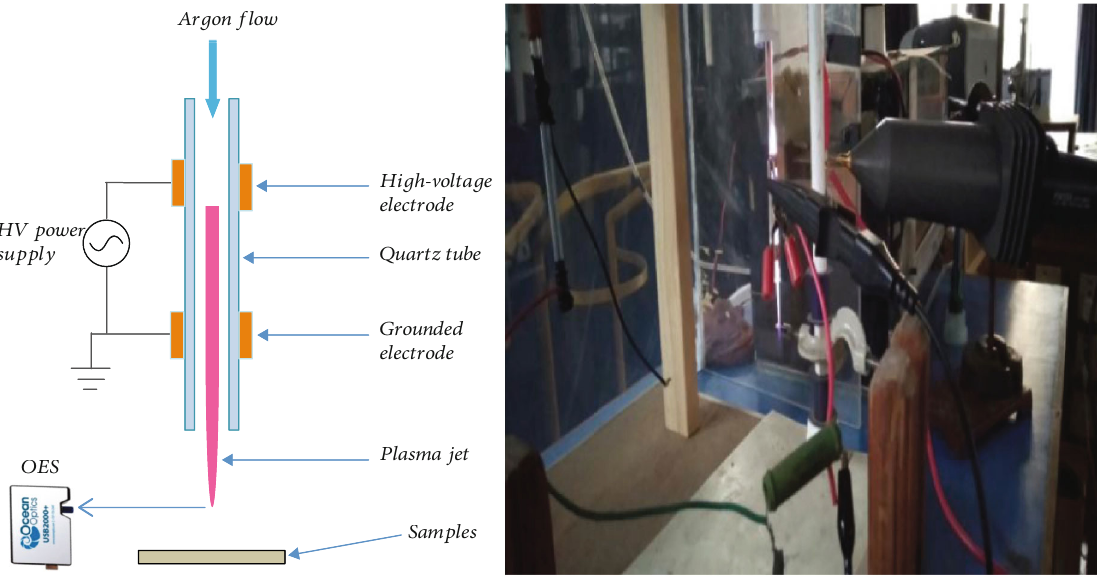
Figure 1: Schematic diagram of the experimental setup and image of the